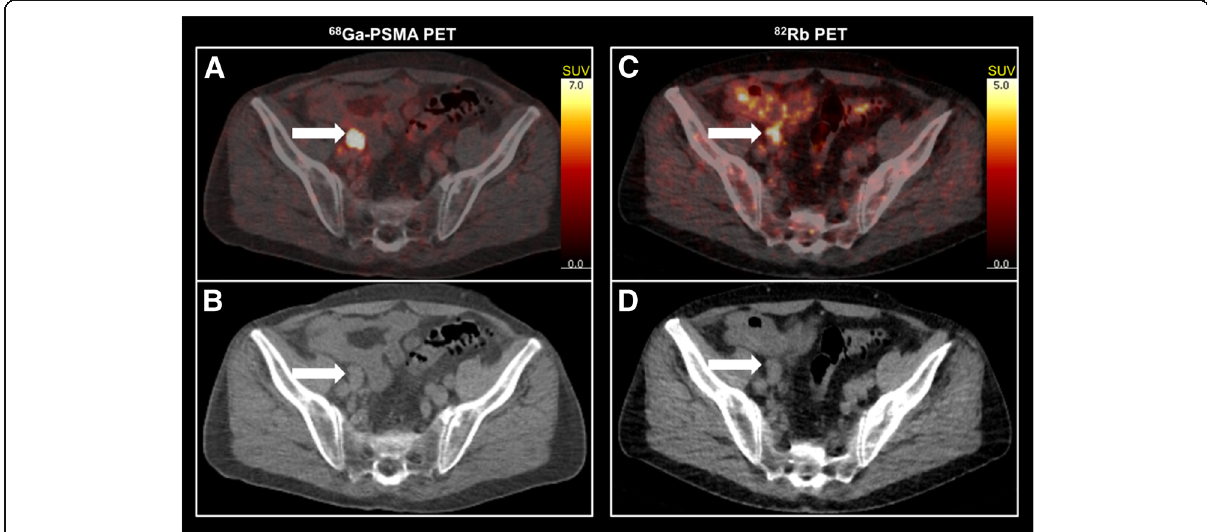
Fig. 3 Images of a pelvic lymph node metastasis (patient 2). To the left, 68 Ga-prostate-specific membrane antigen (PSMA) positron emission tomography (PET)/computed tomography (CT)-fused image ( a ) (SUVmax 43.0) and corresponding low-dose CT ( b ). To the right, 82 Rb PET/CT fused image ( c ) (SUVmax 6.5) and corresponding low-dose CT ( d